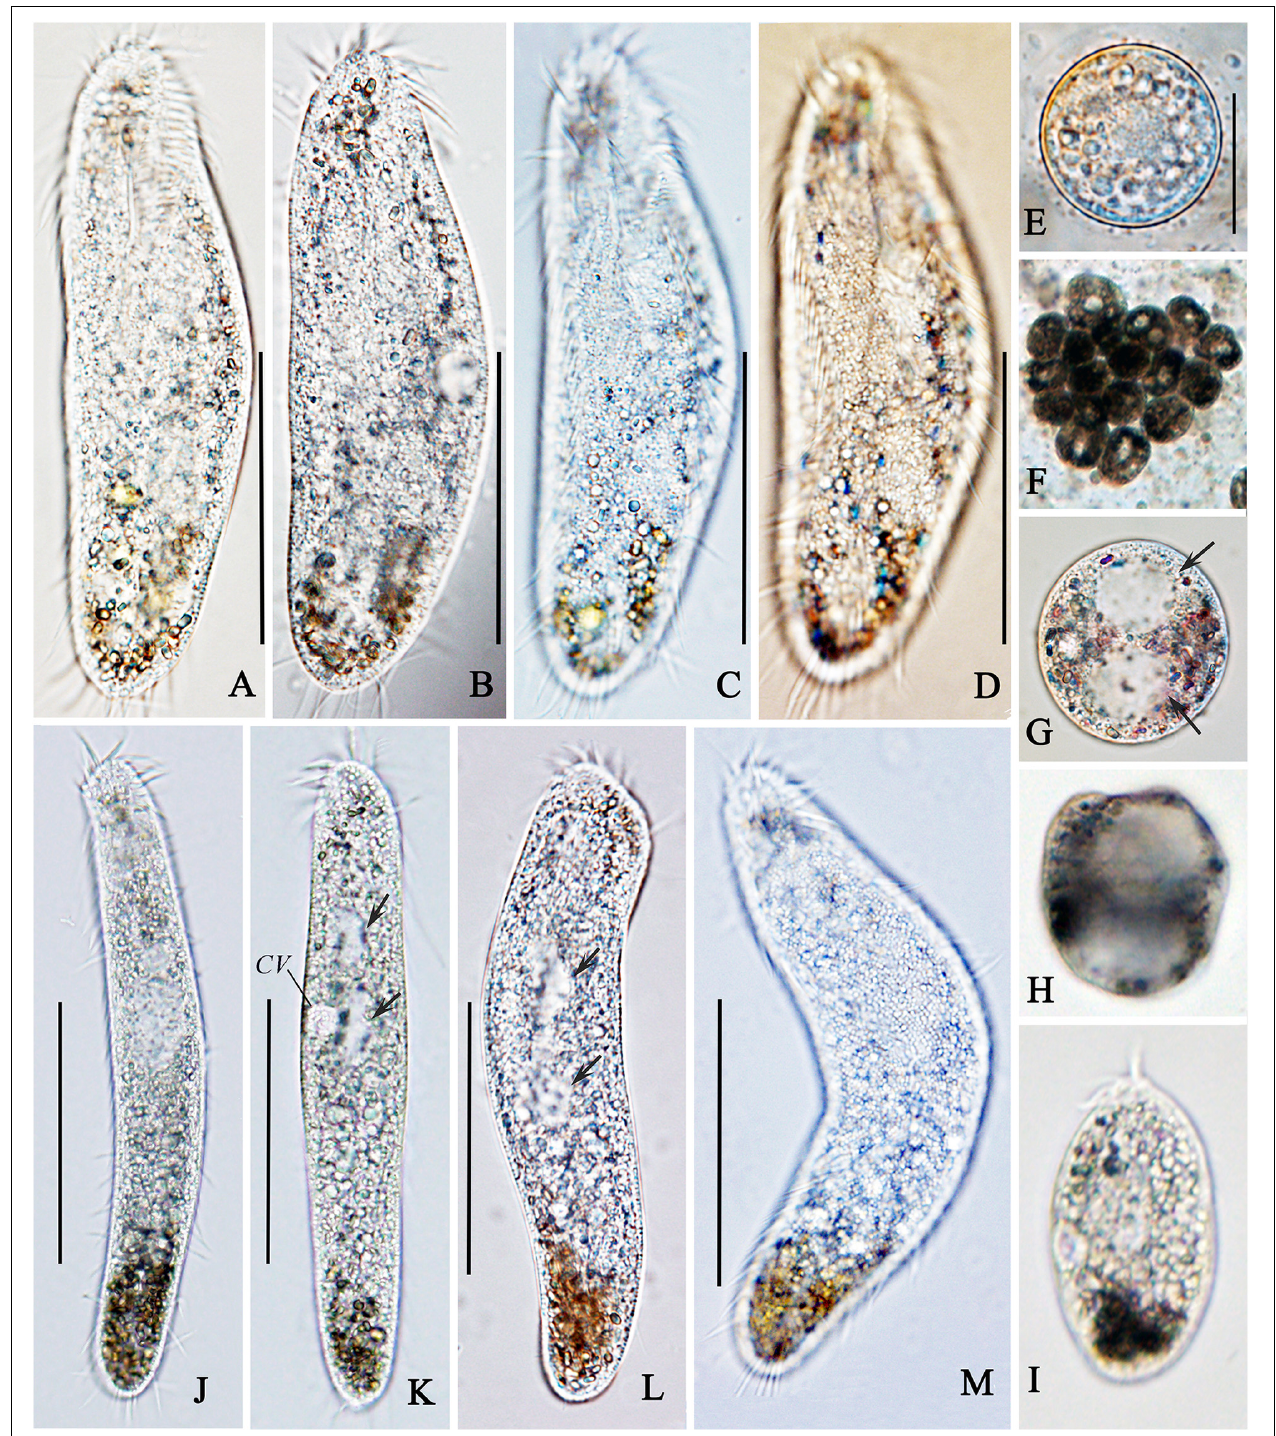
FIGURE 2 | Photomicrographs of normal (A–E) and abnormal forms (F–M) of Oxytricha granulifera granulifera in vivo . (A–D) Typical body shapes of the normal cells. (E) A normal cyst. (F–H) Abnormal cysts; each cyst with two macronuclear nodules (arrows in G ). (I) A newly excysted abnormal cell. (J–L) Ventral view of abnormal forms, showing the changes of body shape, arrows in (K,L) indicating the macronuclear nodules. (M) Cortical granules of an abnormal cell from the dorsal side. CV, contractile vacuole. Scale bars = 50 µ m.